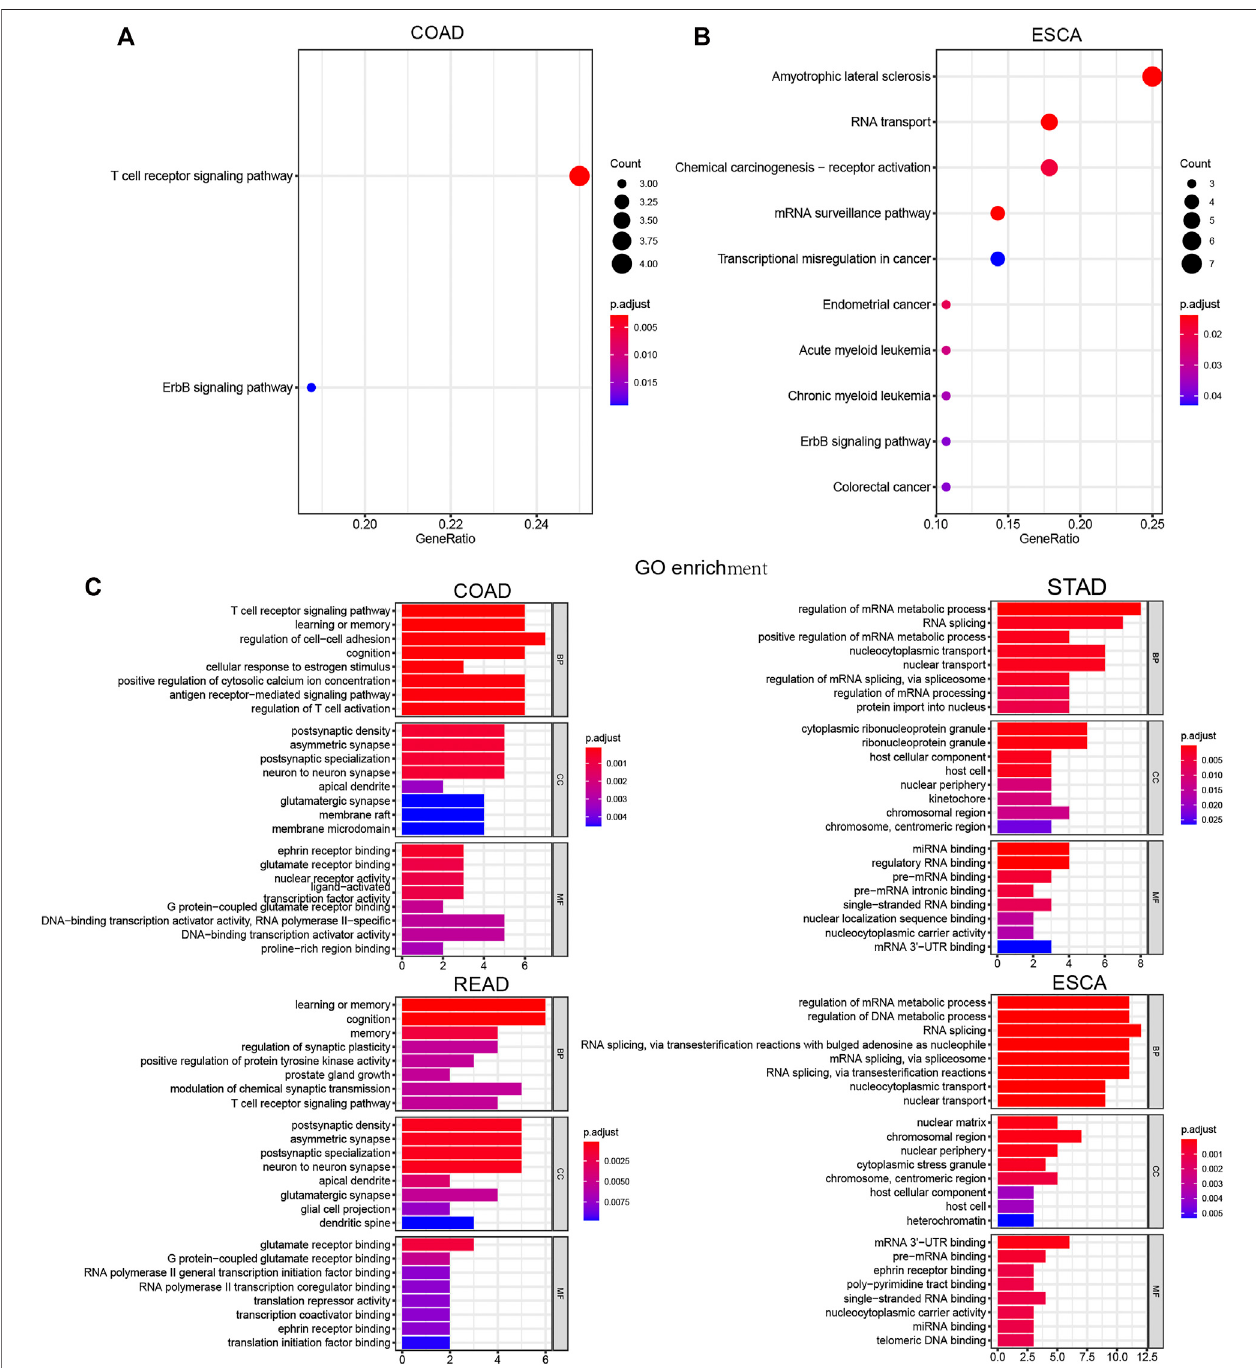
FIGURE 9 | Comprehensively Bioinformatic analysis of LLPS regulators in digestive system neoplasms. (A – B) KEGG analysis of differently expressed LLPS regulators in COAD (A) and ESCA (B) . (C) GO analysis of LLPS regulators in COAD, STAD, READ, and ESCA.